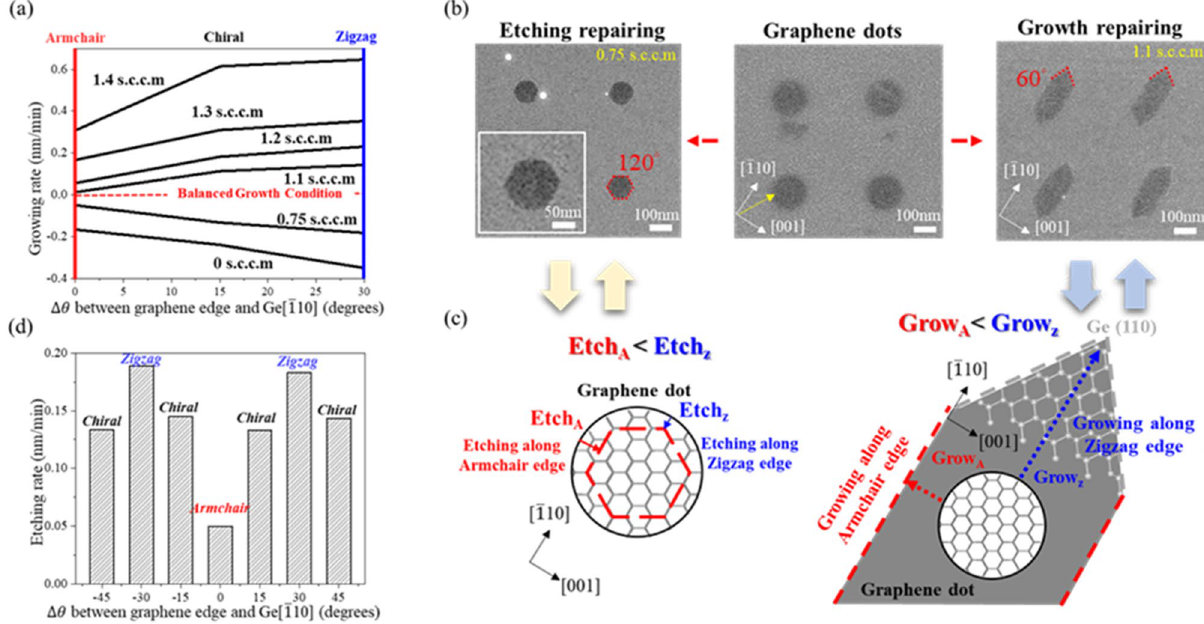
Figure 4. ( a ) Growth rate of the GNRs along with different orientations along Ge[110] under 1.4 s.c.c.m., 1.3 s.c.c.m., 1.2 s.c.c.m., 1.1 s.c.c.m., 0.75 s.c.c.m., and 0 s.c.c.m. CH4 conditions. ( b ) SEM images after regrowth the graphene dots with 1.1 s.c.c.m. and 0.75 s.c.c.m. CH4 precursor. ( c ) The schematic diagram of the etching and growth of graphene dots along with armchair and zigzag edges. ( d ) Etching rate of the GNRs along with different angles under 0 s.c.c.m. CH4 condition.